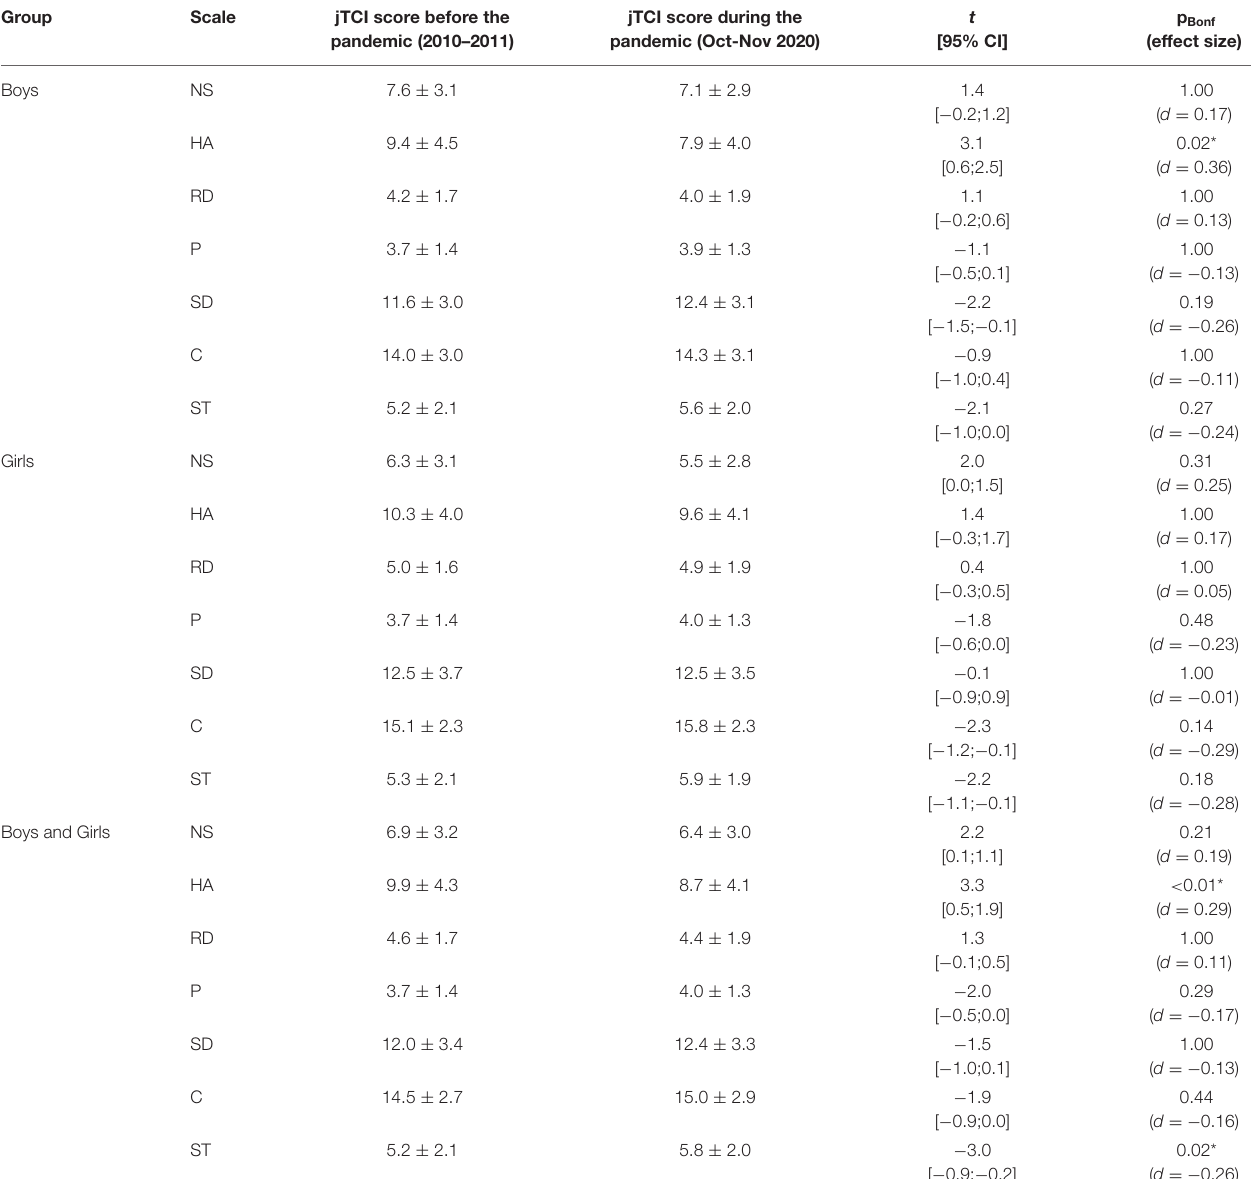
TABLE 3 | Comparison of the junior Temperament and Character Inventory (jTCI) data collected in Italian third, fourth and fifth graders before [2010–2011, (77)] and during the COVID-19 pandemic (October-November 2020). Group